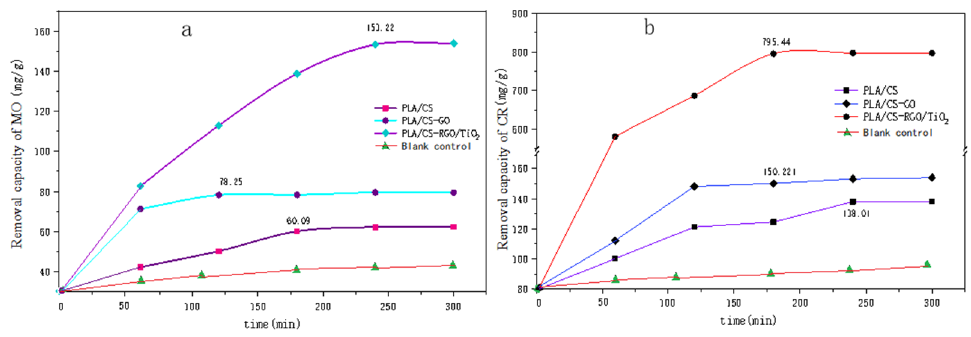
Figure 10. Removal capacity of ( a ) MO and ( b ) CR by PLLA/CS, PLLA/CS–GO, and PLLA/CS– GO/TiO 2 . mg/g refers to the mass (mg) of pollutants removed by the fiber composite material per unit mass (g).